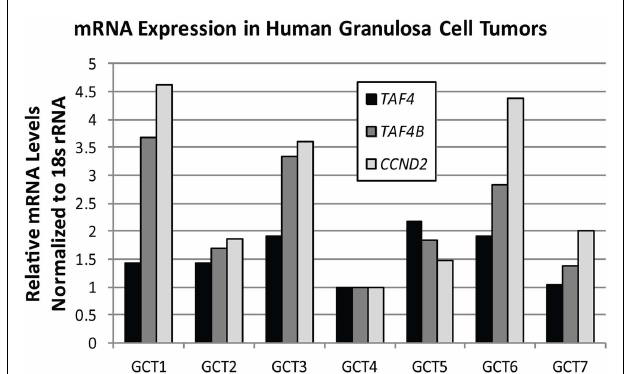
FIGURE 6 | TAF4B correlates with CCND2 mRNA levels . Quantitative RT-PCR analysis of TAF4A (black bars), TAF4B (dark gray bars), and CCND2 (light gray bars) mRNA levels in human granulosa cell tumors. Pearson correlation co-efficient ( R ) for TAF4B and CCND2 = 0.93; TAF4A and CCND 2 =